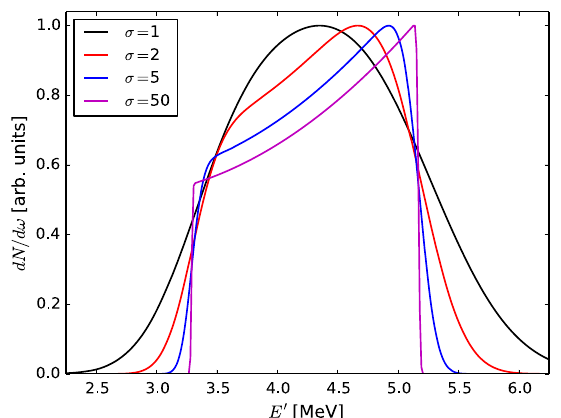
FIG. 6. Same as Fig. 1, only with varying width of the laser pulse σ